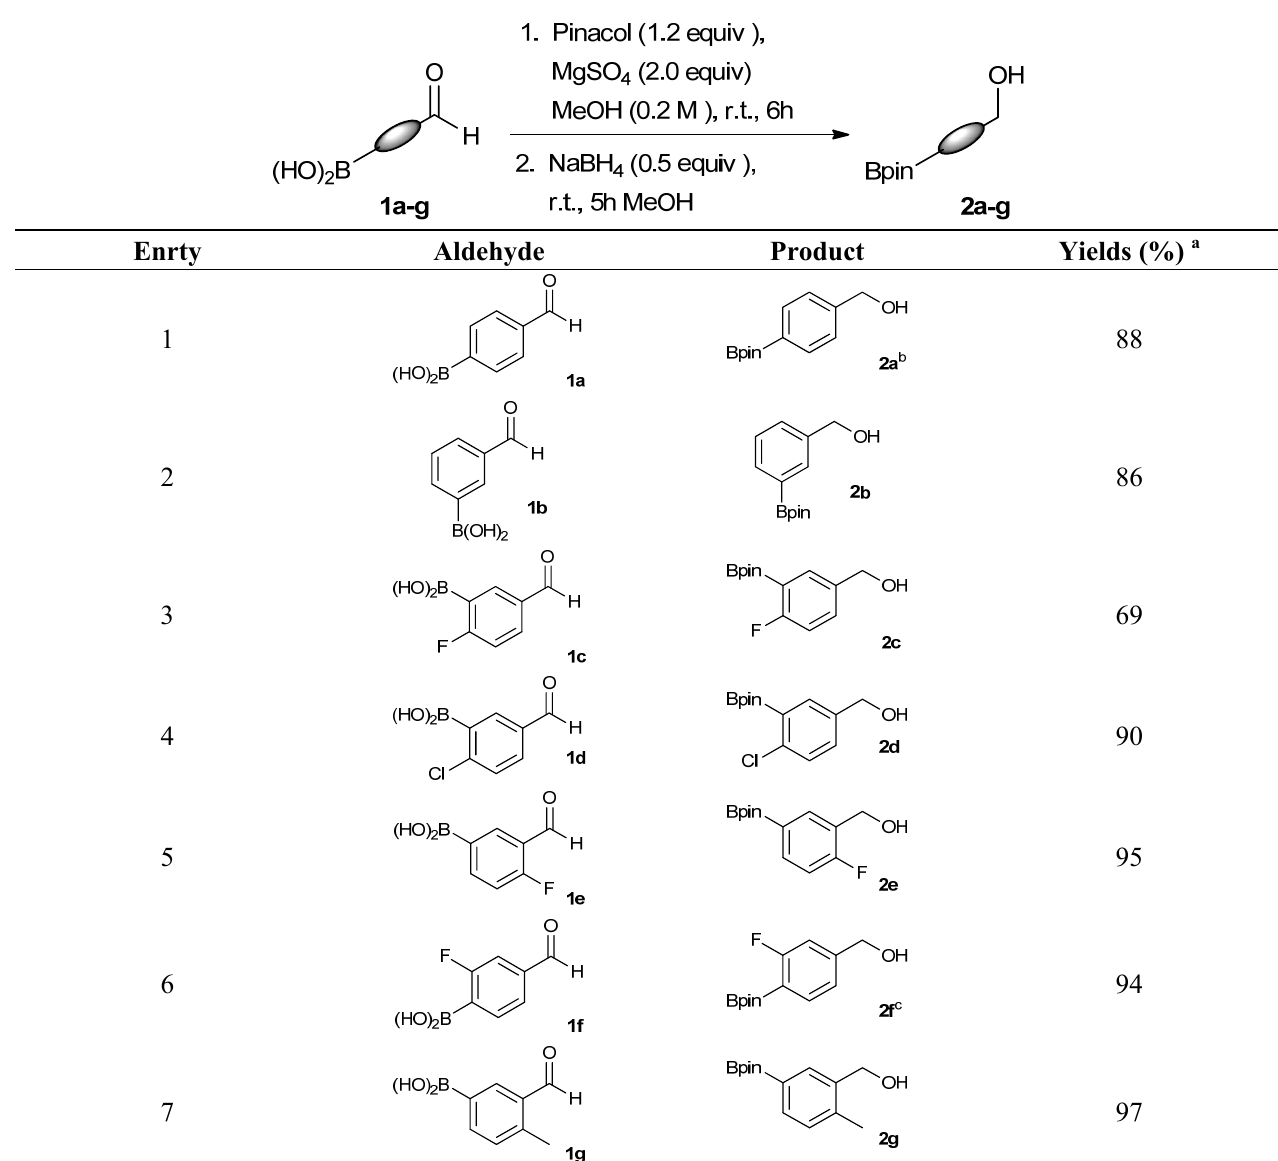
Table 1. Synthesis of hydroxymethylphenyl boronate